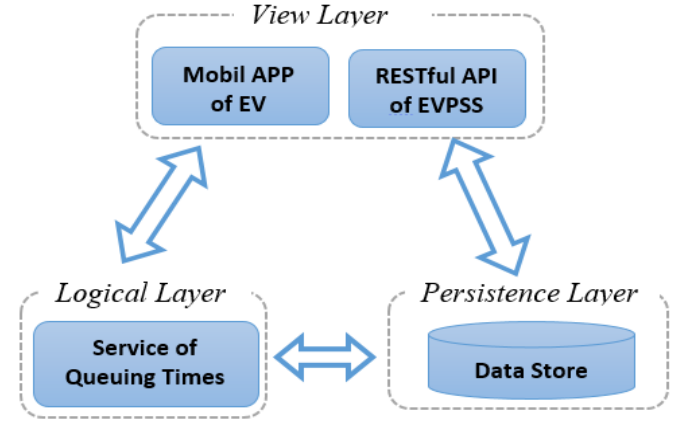
Figure 2. Three-layer framework of application. Reproduced with permission from [12].